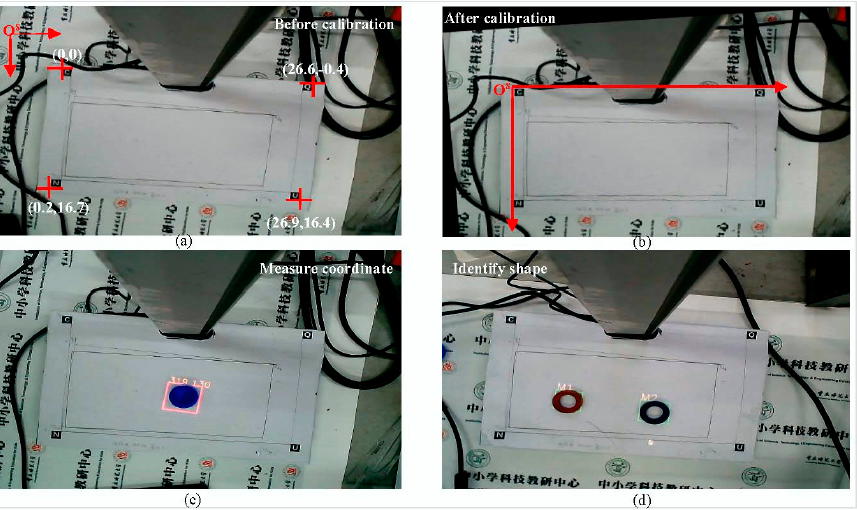
Figure 2. Illustrations of CCD-based detection of coordinates and shapes of real objects on projection plane. ( a ) The captured CCD image before calibration, where four points are given for estimating the homography matrix; ( b ) the image after calibration; ( c ) the DLP display of the coordinate of a cover; and ( d ) identifying two